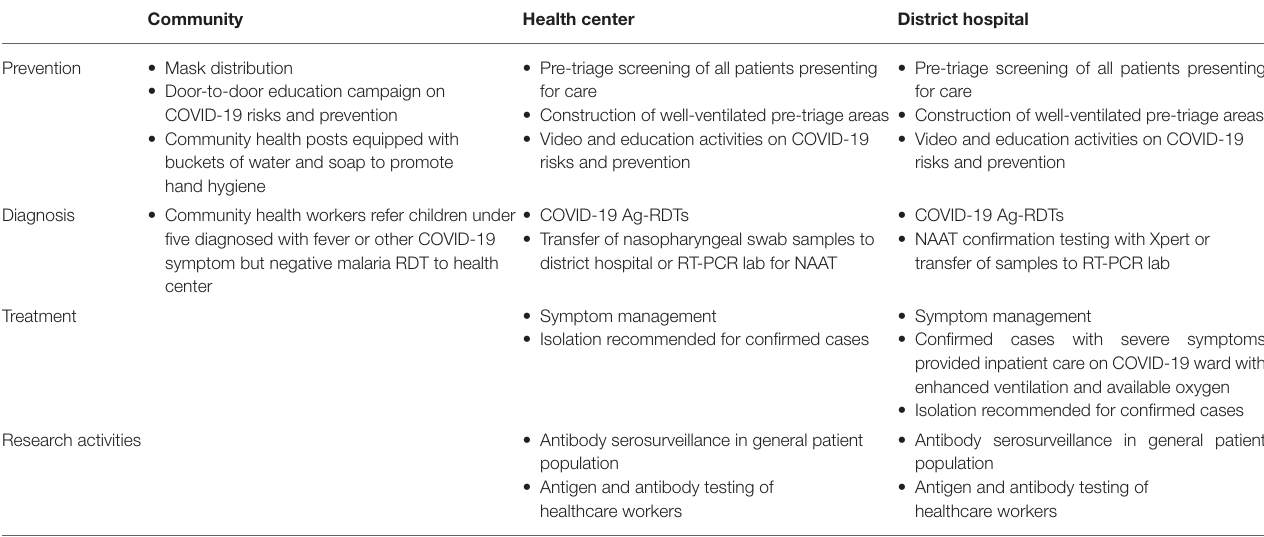
TABLE 1 | COVID-19 interventions across the levels of the health system in Ifanadiana